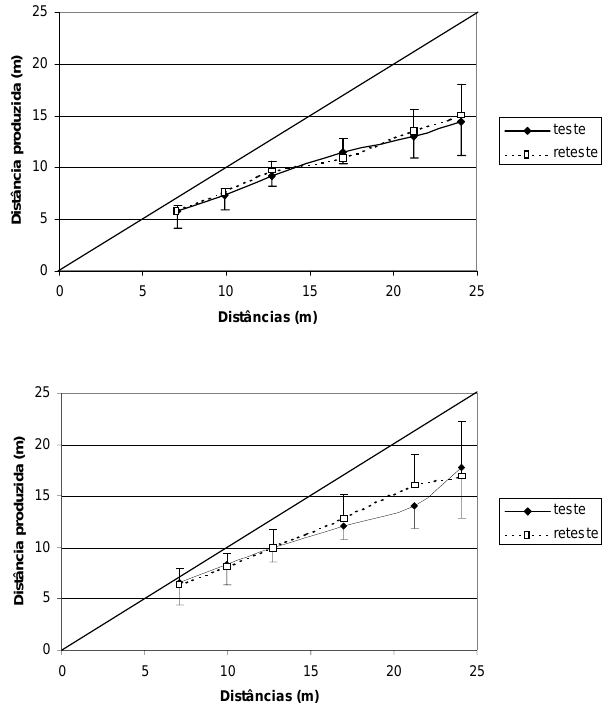
Figura 4. MØdia e desvio-padrªo das dist(cid:226)ncias produzidas pelos participantes durante o prØ-teste e o p(cid:243)s-teste. a. tarefa em linha reta; b. tarefa em tri(cid:226)ngulo. Psicologia: Reflexªo e Cr(cid:237)tica, 2004, 17(2),